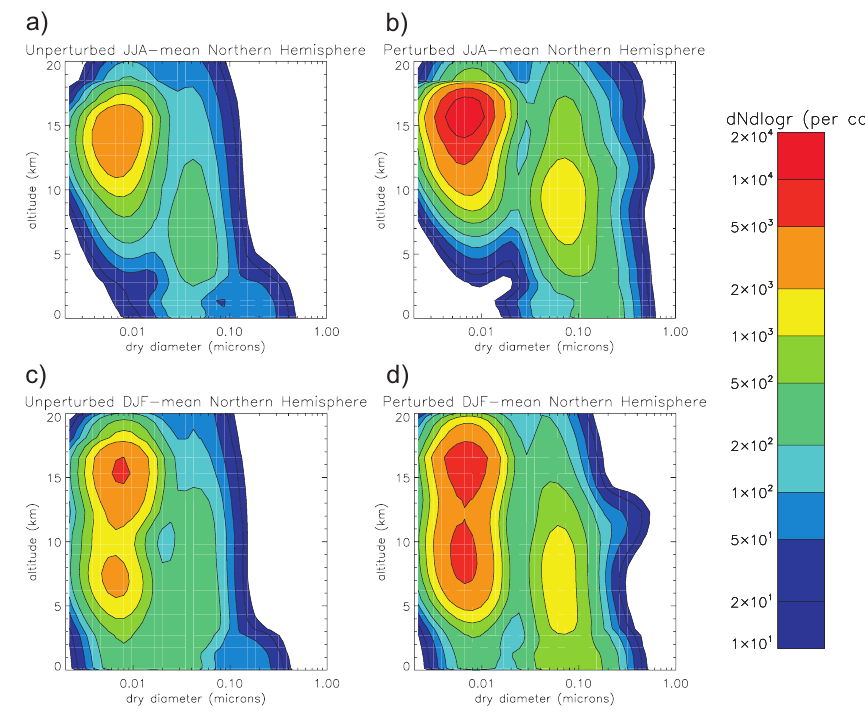
Fig. 8. Simulated zonal 3-month mean number-size distribution averaged over the Northern Hemisphere for (a) L-s unperturbed run, (b) L-s perturbed run, (c) L-w unperturbed run, (d) L-w perturbed run. With nucleation mode: ( d p < 0.01µm); Aitken mode: (0.01 <d p < 0.1µm);